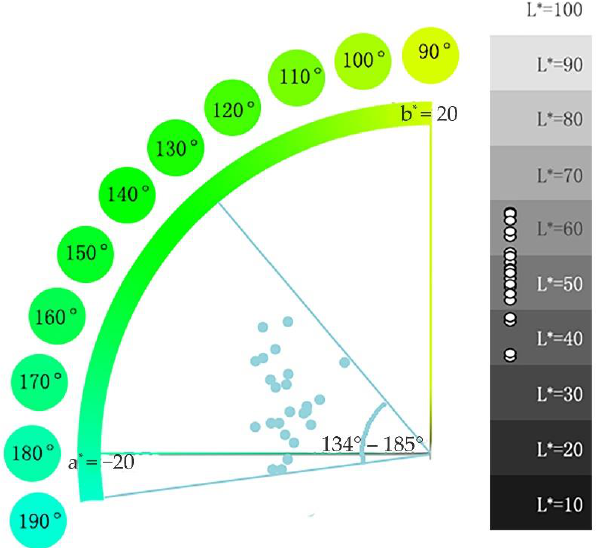
Figure 3. Colour distribution of samples in the CIELAB space. H ab ranges from 134 ◦ to 185 ◦ . L* ranges from 41 to 68 (from Wang H.